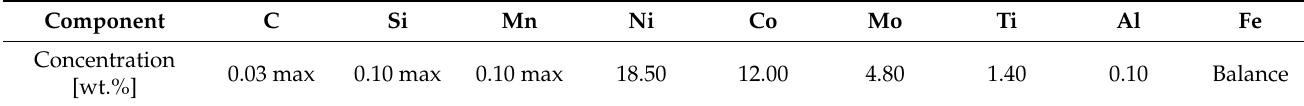
Table 2. Chemical composition of the Maraging 350 steel